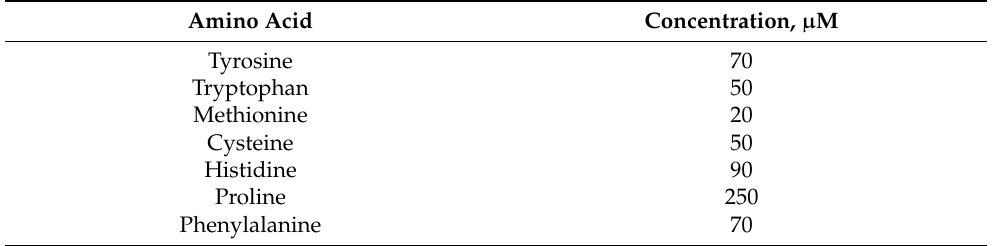
Table 1. Concentrations of amino acids added to Hank’s Balanced Salt Solution [56]. Amino